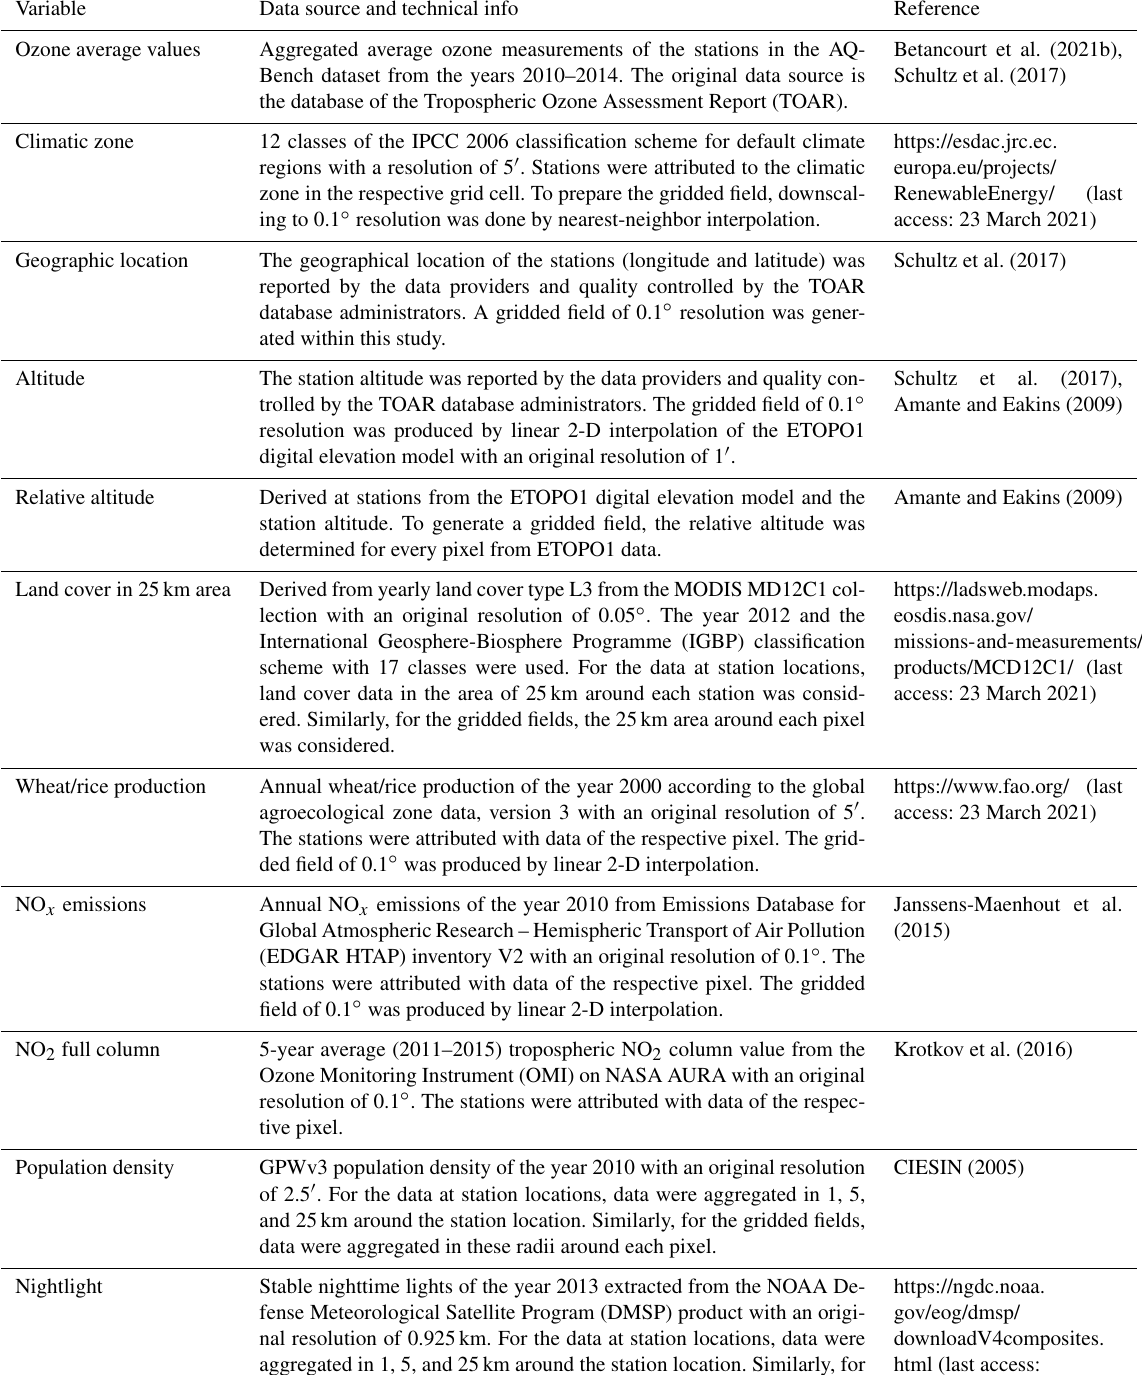
Table A1. Technical details on the data used in this work. For more information on the station location data, refer to Betancourt et al. (2021b). Please note that “land use in 25km area” comprises all the different land cover